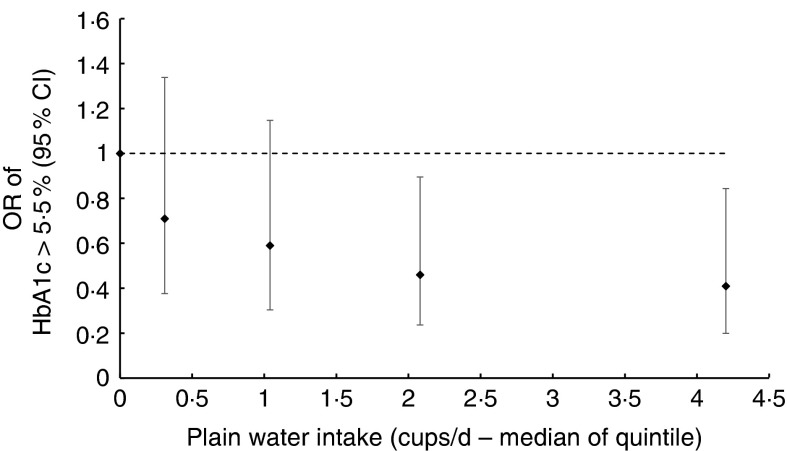
OR of glycated Hb (HbA1c) ≥5·5 % according to median plain water intake of each
quintile of consumption in men. The likelihood ratio test suggested no evidence of
deviation from linearity (P=0·600), calculated by comparing nested
regression models.